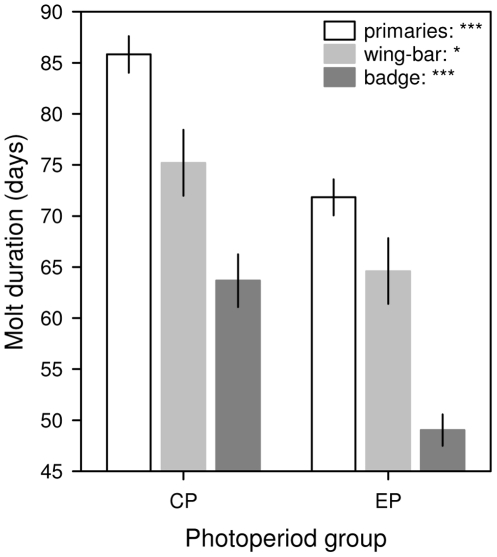
The effect of experimental photoperiod manipulation on molt duration.The duration of replacing the primaries (open columns), wing-bar (light grey columns) and badge feathers (dark grey columns) was significantly shorter if birds were held at experimentally accelerated ‘EP’ photoperiod as related to those at natural-like ‘CP’ photoperiod. Mean ± SE are shown. ‘*’ P<0.05, ‘***’ P<0.0001.